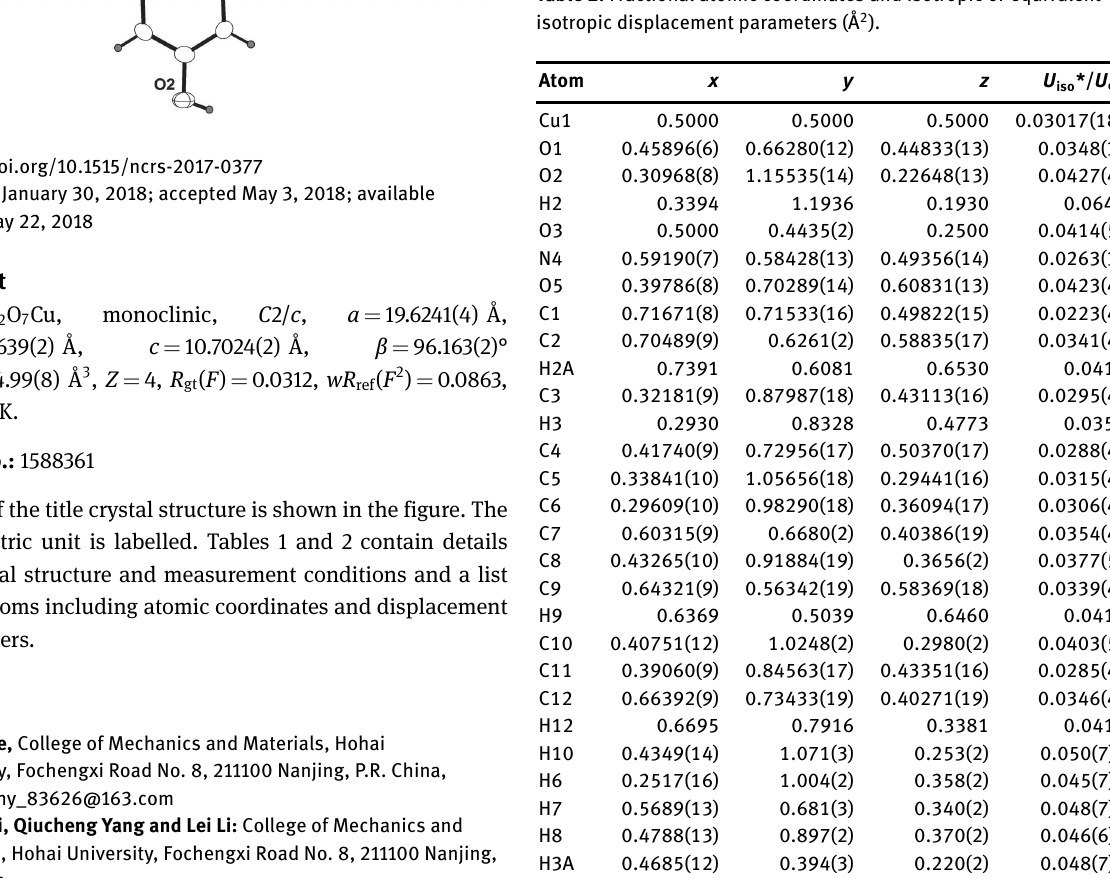
Table 2: Fractional atomic coordinates and isotropic or equivalent isotropic displacement parameters (Å 2